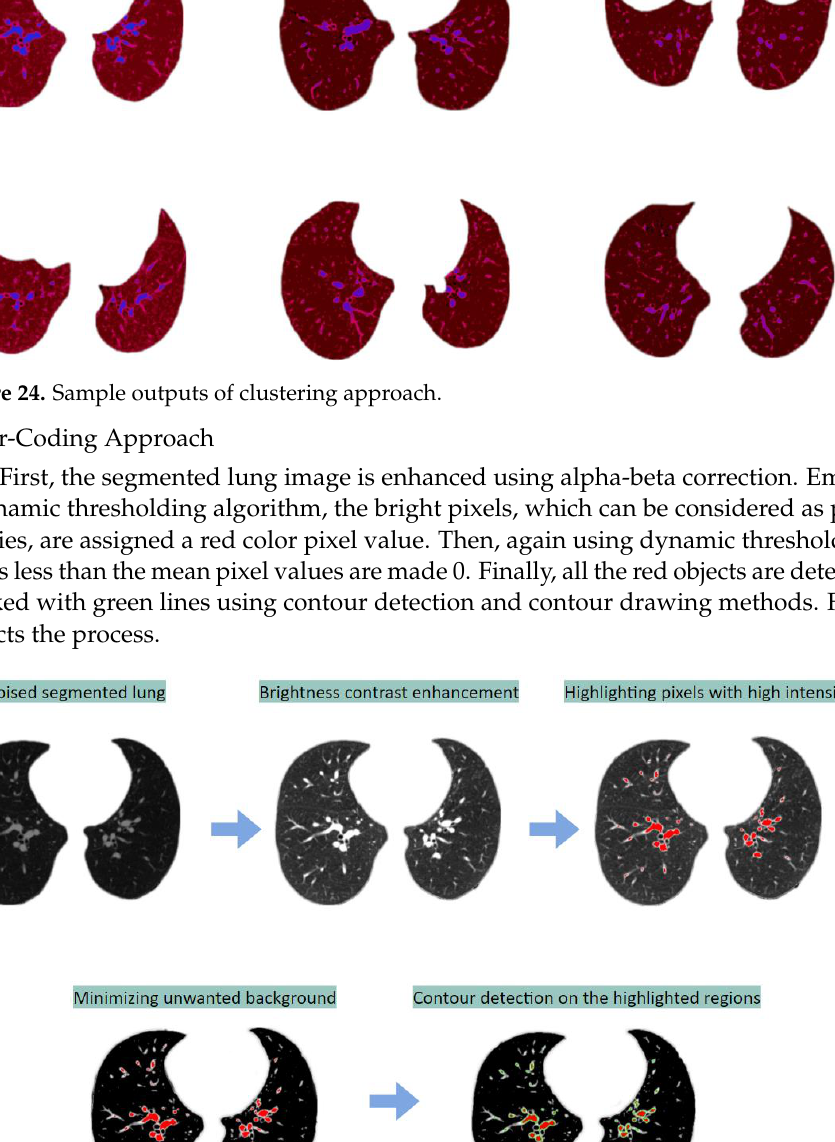
Figure 25. Segmentation of BA from the lungs using the color-coding method.